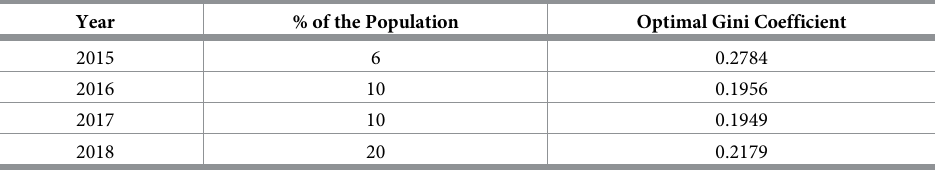
Table 1. Maximum reported cluster size (MRCS) from 2015–2018 in Zimbabwe determined using the Gini